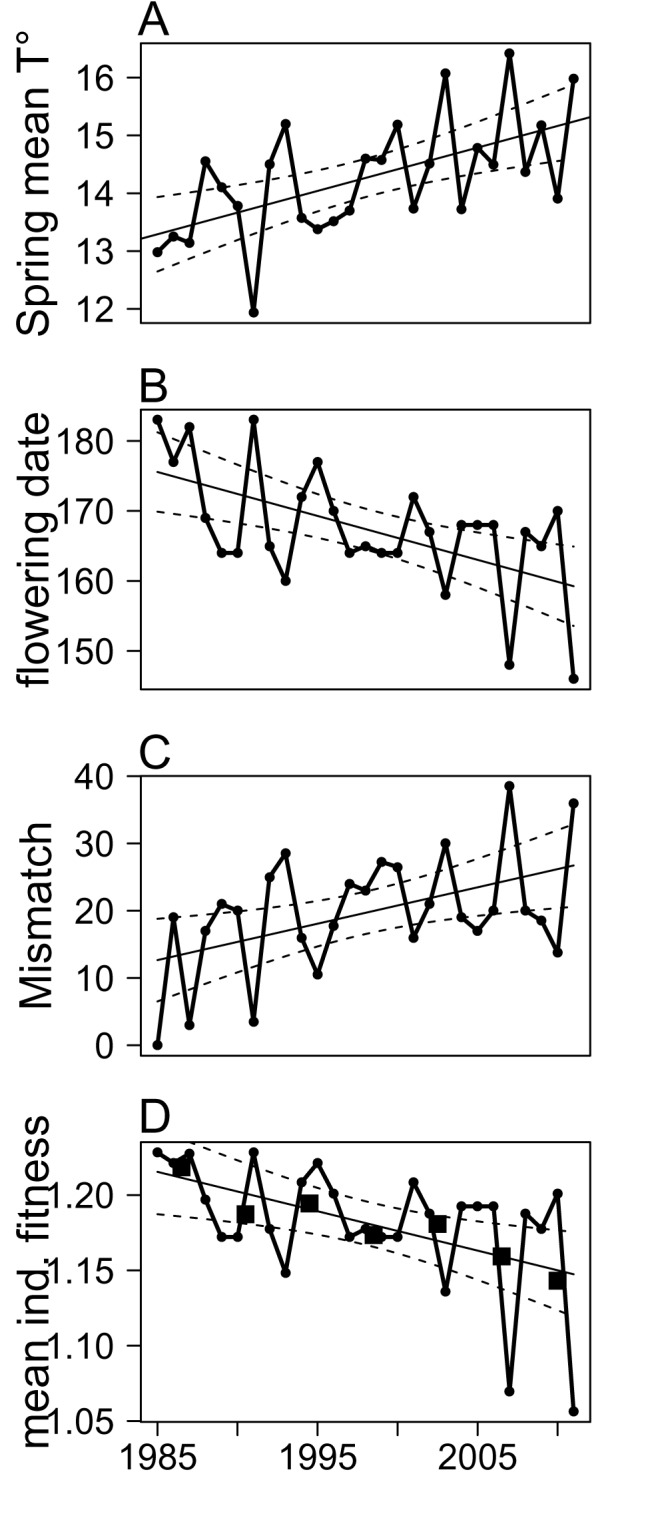
Temporal variation in spring temperature (A), flowering date in the vineyards of the Champagne region (B), the observed population mean of the mismatch between flowering date and median parturition date (C), and mean individual fitness predicted from the IPM (D) in the roe deer population of Trois Fontaines, France from 1985 to 2011.The mismatch was estimated as the difference between median birth date and annual flowering date in the Champagne vineyards. We standardized this measure (by subtracting the observed value of the mismatch in the first year of study (1985) from this variable) to obtain a relative measure of mismatch ranging from 0 in 1985 to 36 d in 2011. Predicted trends are presented as black lines with 95% confidence intervals (dashed lines). Geometric means of mean individual fitness were calculated over periods of 4 y (black squares).